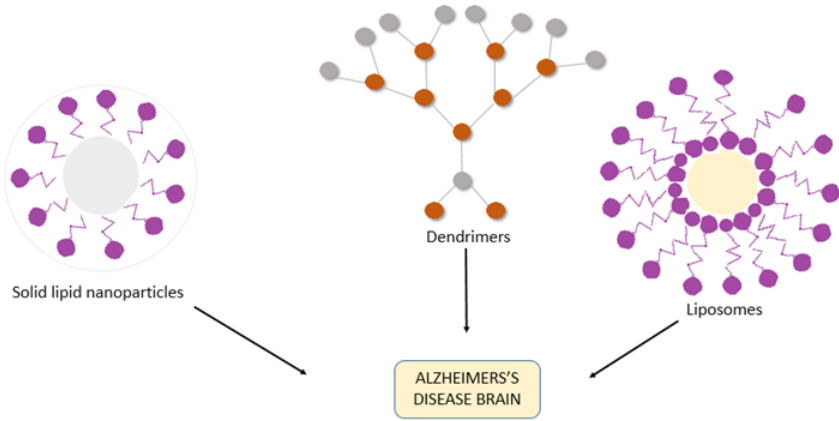
Figure 4. Diagrammatic representation of drug delivery options using nanotechnology for therapeutic purposes in AD.